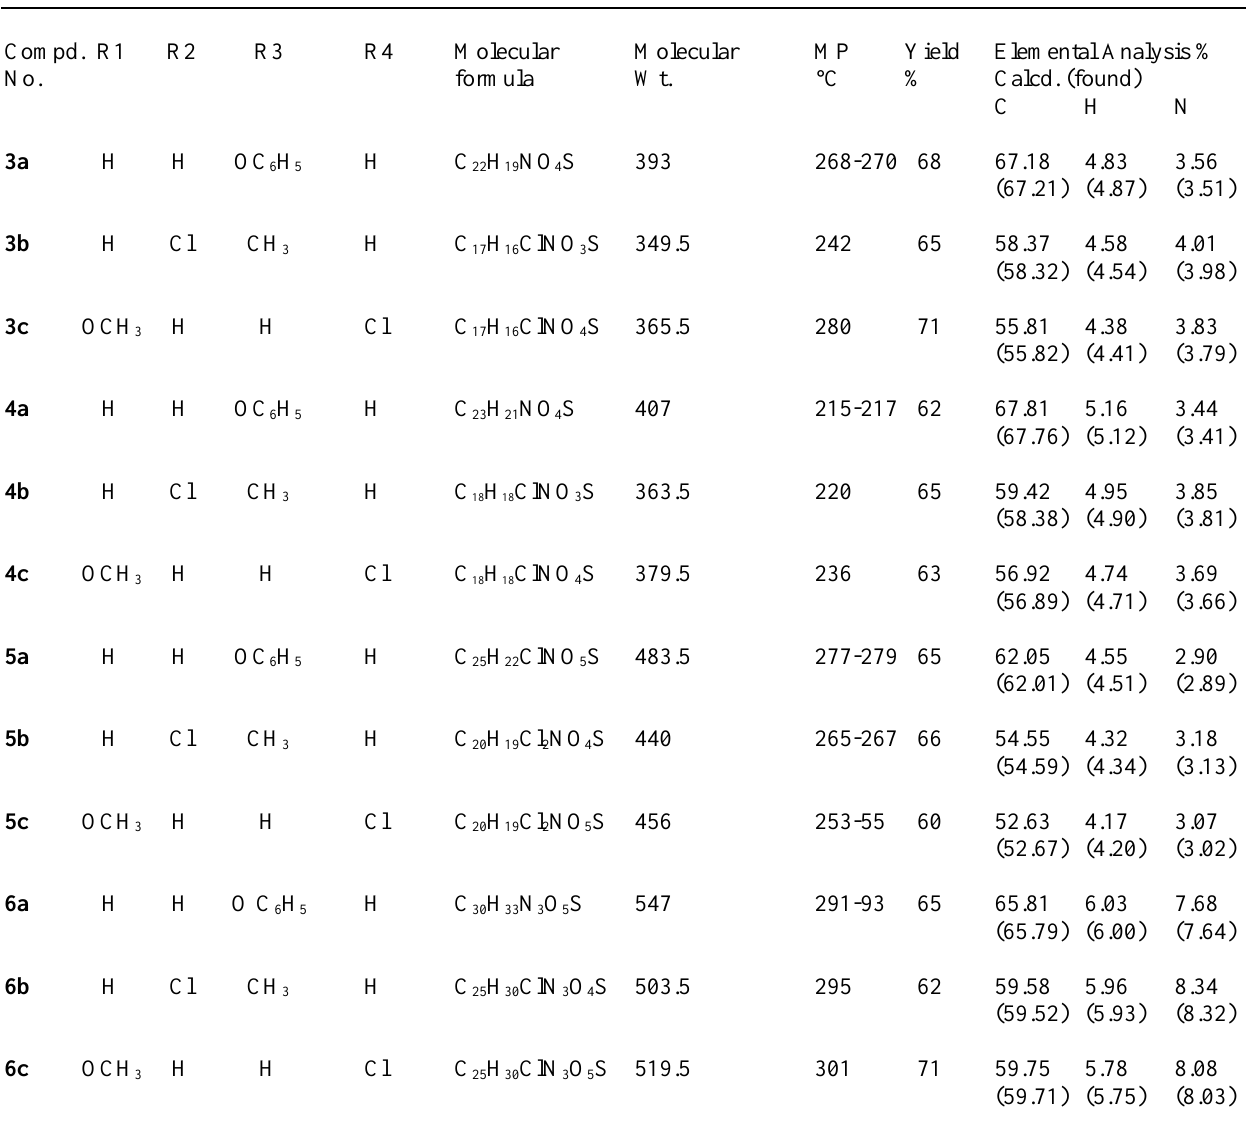
Table 1. Characterization data of 1,5-benzothiazepine